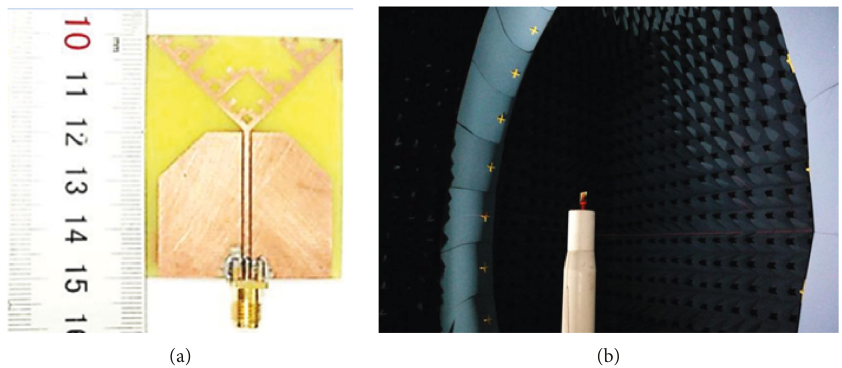
Figure 9: Prototype of the antenna and test scenario in anechoic chamber.